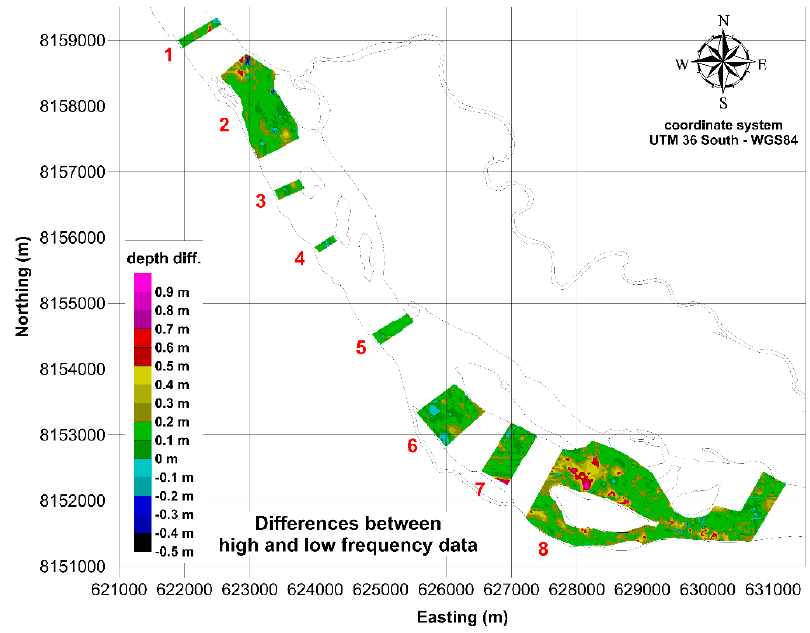
Figure 8. Map of bathymetric differences between high and low frequency data. Positive values indicate low frequency depths greater than high frequency ones.